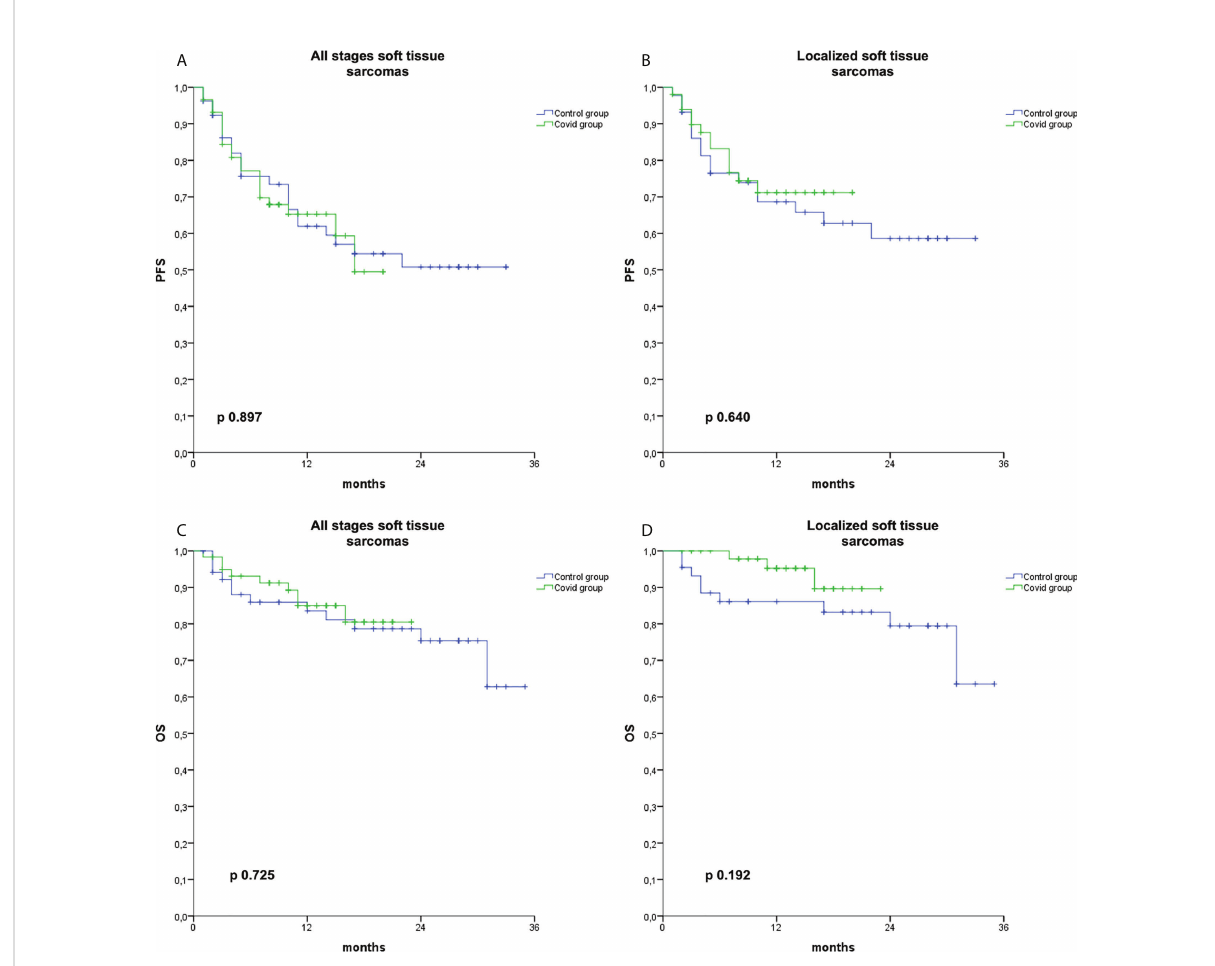
FIGURE 3 Kaplan – Meier curves for PFS and OS in soft tissue sarcomas. Kaplan – Meier curve for PFS in soft tissue sarcomas irrespective of the stage at diagnosis (A) , for PFS in localized soft tissue sarcomas (B) , for OS in soft tissue sarcomas irrespective of the stage at diagnosis (C) , and for OS in localized soft tissue sarcomas (D) in the Covid group (green) and the Control group